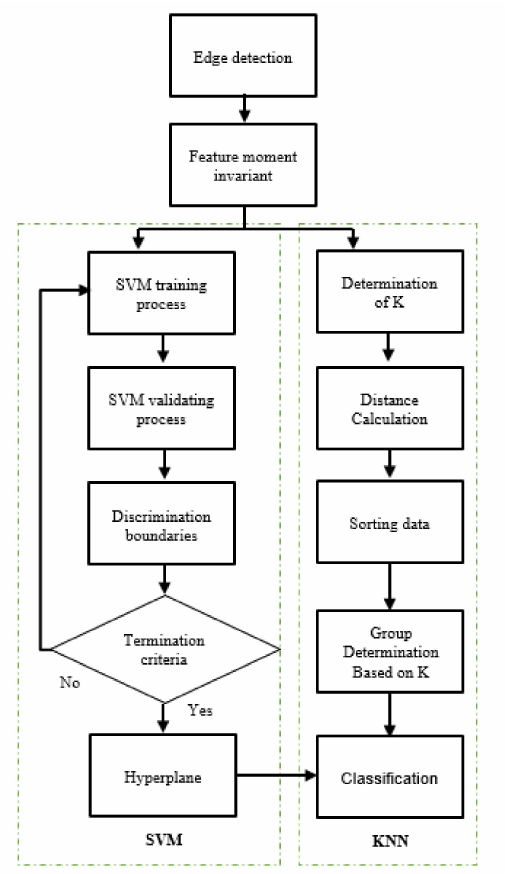
Figure. 2. The leaves classification process